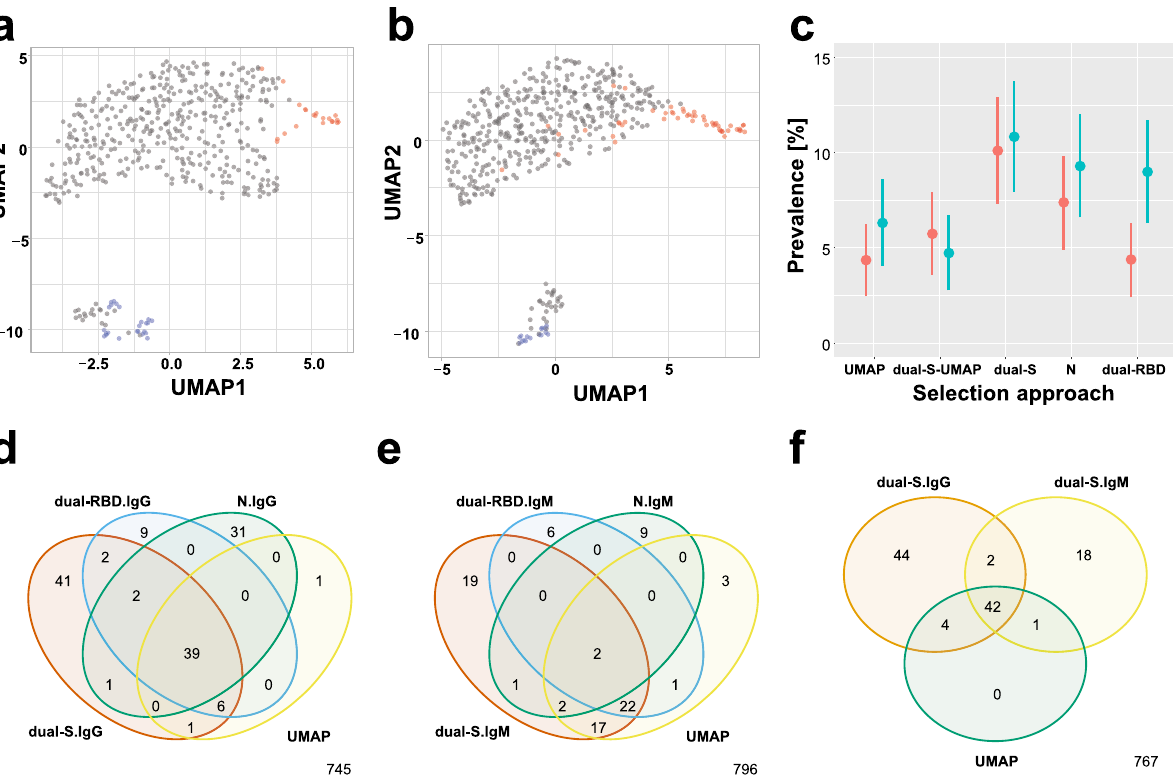
Fig. 2 Seroprevalence and diversity of immune response. a , b The UMAP (Uniform Manifold Approximation and Projection) clustering method was used to identify samples in study set 1 ( a ) and set 2 ( b ) with antibodies against SARS-CoV-2, data from IgG and IgM, as well as the included S, RBD, and N proteins were combined. The color codes indicate the samples from the population (gray), negative controls collected prior to 2020 (red), and PCR-con fi rmed positive controls (blue). UMAP parameters for a were n_neighbors: 25, min_dist: 0.5, seed: 42 and for b were n_neighbors: 27, min_dist: 0.5, seed: 254. c Seroprevalence determine by different selection methods for study set 1 (red) set 2 (petrol): UMAP clustering, overlap in IgG response against two S proteins (dual-S),